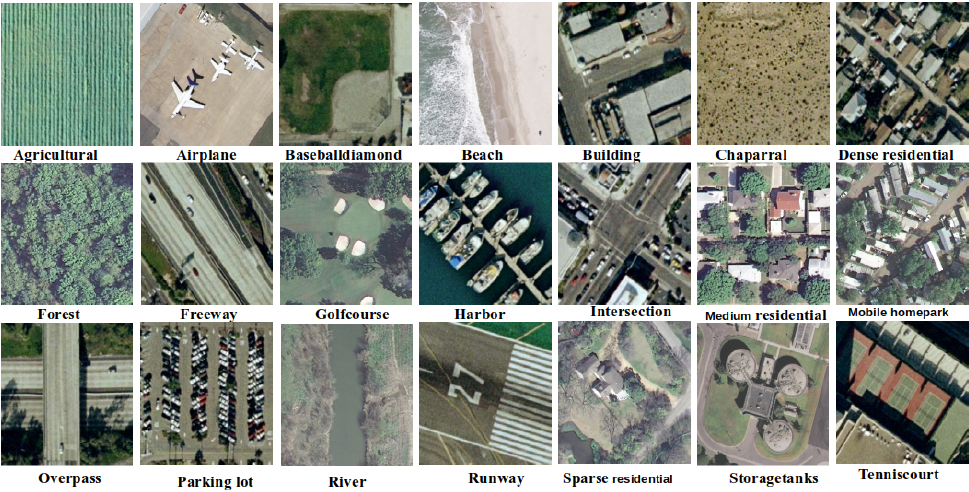
Figure 2. Example images associated with 21 land use categories in the UC Merced data